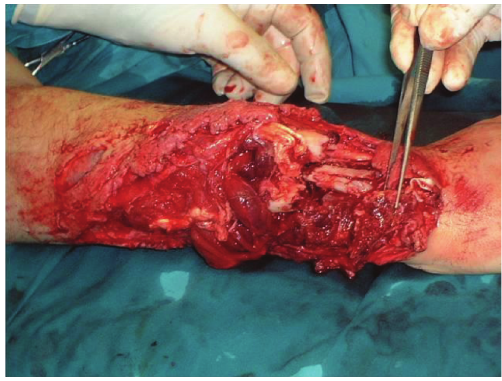
Figure 1: Preoperative crush injury right forearm.